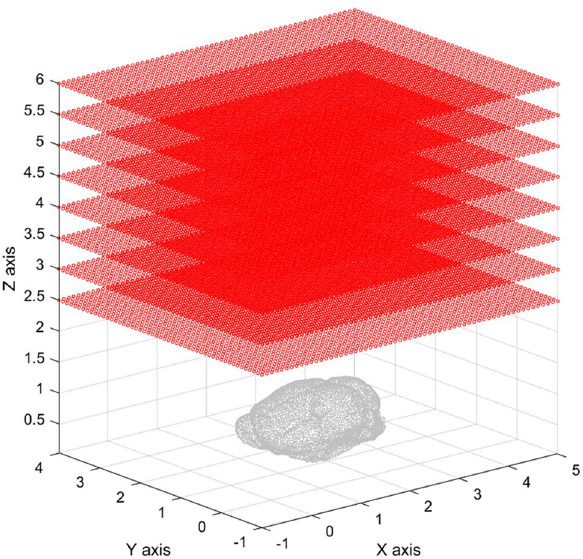
Figure 1. XY scanning plane of the sensor from Z = 2.5 cm to Z = 6.0 cm and an interval of 0.5 cm.